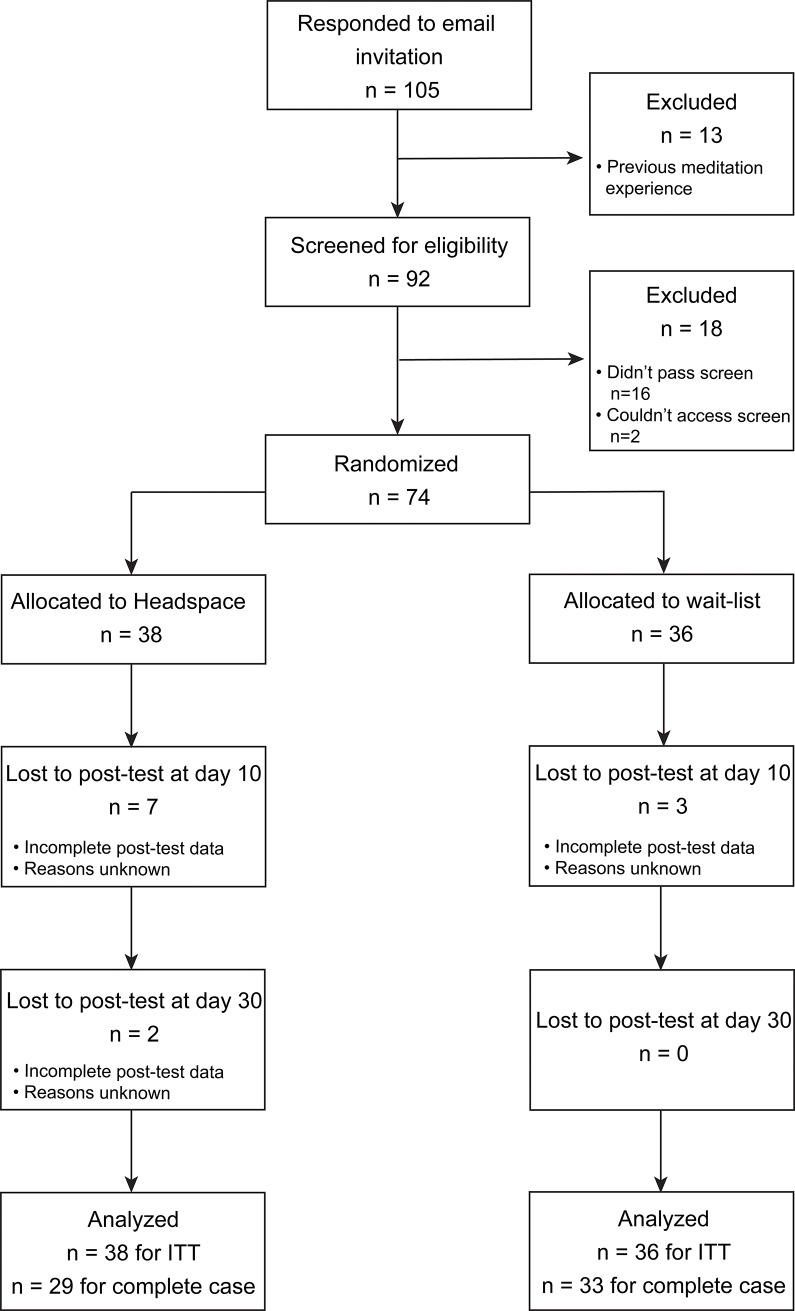
CONSORT diagram of participant flow through the study.